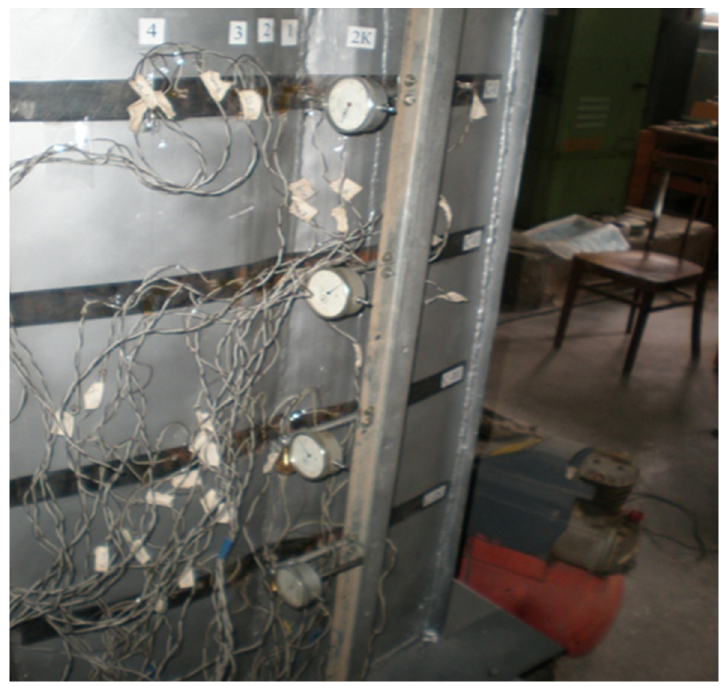
Figure 2. Placement of ICH-04 dial indicators.